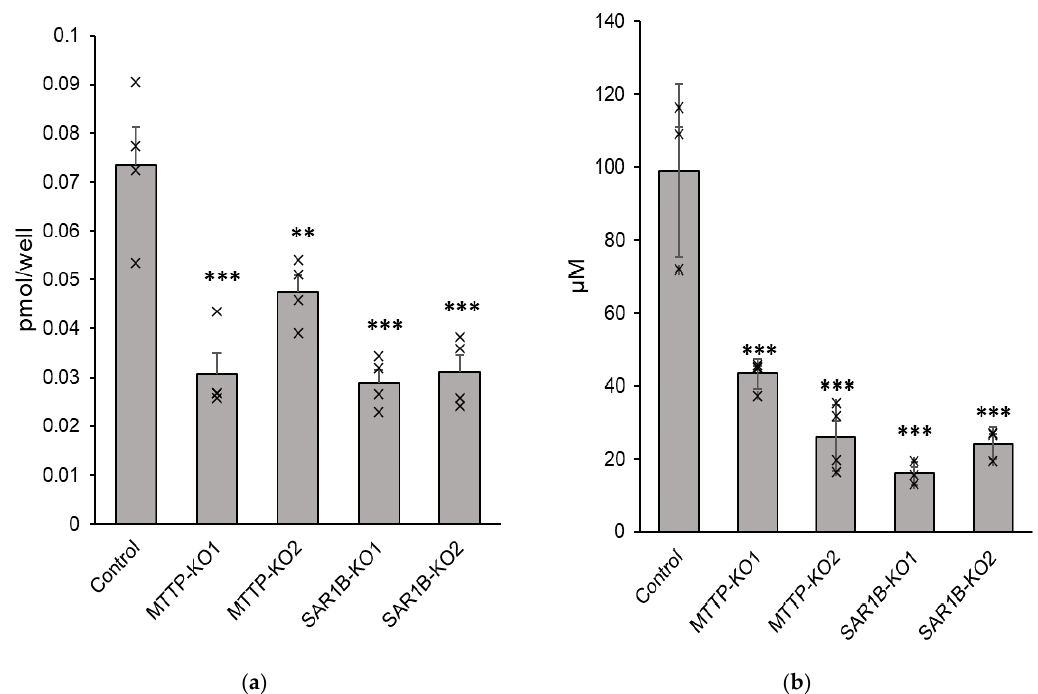
Figure 8. ( a ) Cholesterol and ( b ) triglyceride basolateral secretion in MTTP and SAR1B KO Caco-2/TC7 cells compared with wild-type Caco-2/TC7 cells. Cells were cultured on inserts for 21 days and were incubated with mixed micelles for 16 h. Triglyceride and cholesterol levels in the basolateral medium were quantified by fluorimetric assays. Data are expressed as means ± SEM ( n = 4). Asterisks indicate a statistically significant difference in cholesterol concentrations between control and KO clones (** p < 0.001, *** p <